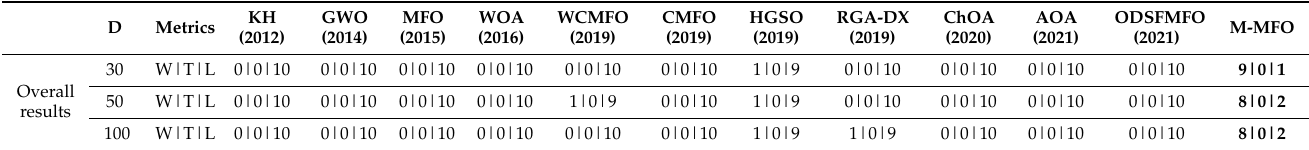
Table 5. The overall results of the M-MFO and comparative algorithms on composition test functions.